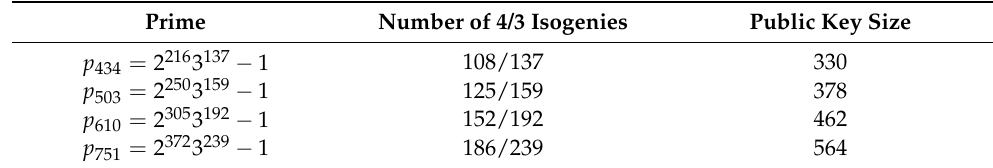
Table 1. Public parameters